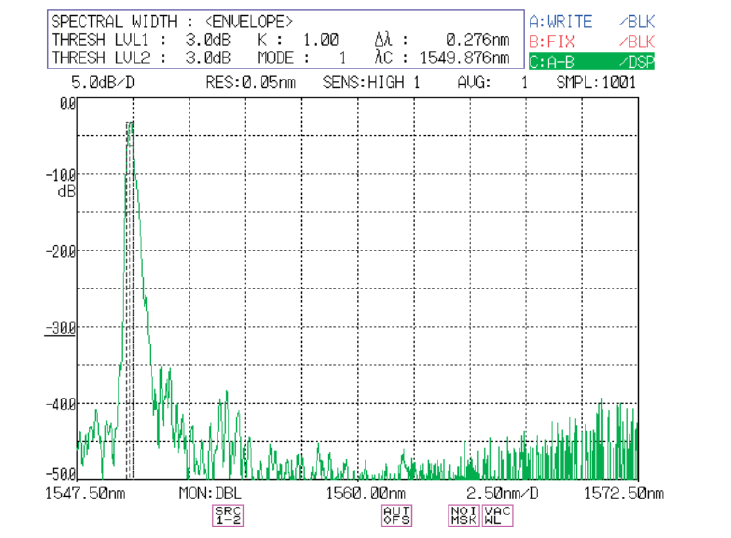
Figure 5. Spectral responses of the band-pass output of